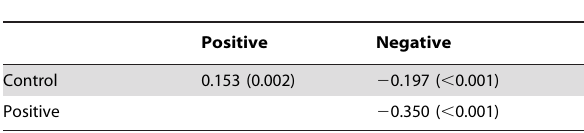
Table 2. Mean community dispersion (Bray-Curtis distances and corresponding p-values) from Tukey’s HSD tests for comparisons of the density treatments (positive density effects, in which protozoan density in the introduced aliquots was negatively correlated with order of introduction, first high, then intermediate, then low; control, no correlation; and negative density effects, in which the density was positively correlated with the order of introduction, first low, then intermediate, then high) and (b) the sequence treatments corresponding to the six possible orders of introduction of experimental species A, B, and C into the